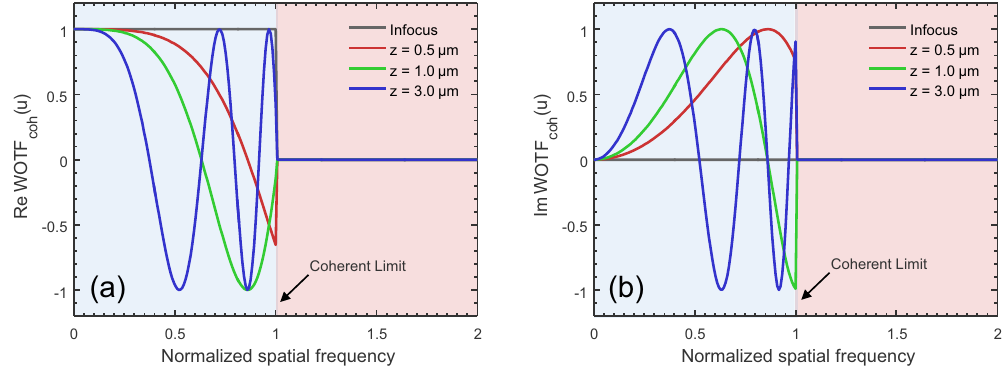
Figure 2. The WOTF coh for various defocus distances ( NA obj = 0.8, λ = 550 nm, the spatial frequency coordinate is normalized against the coherent resolution limit NA obj / λ ). ( a ) Real part of WOTF coh (amplitude CTF); ( b ) Imaginary part of WOTF coh (phase